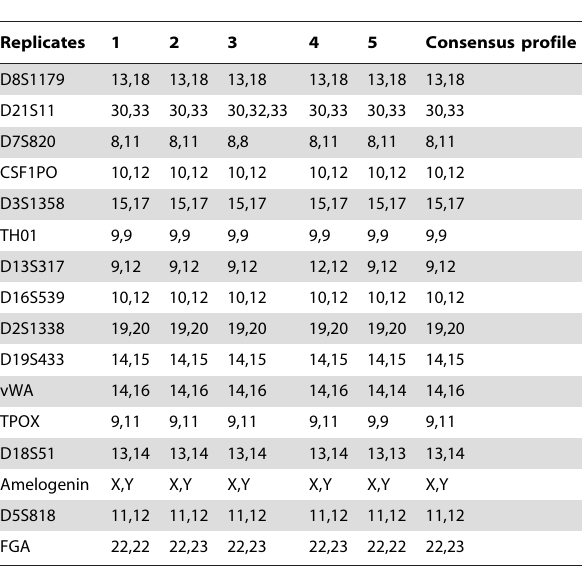
Table 3. Identification of a consensus single-person genotype by LCM and LV-PCR from a sexual assault casework sample.